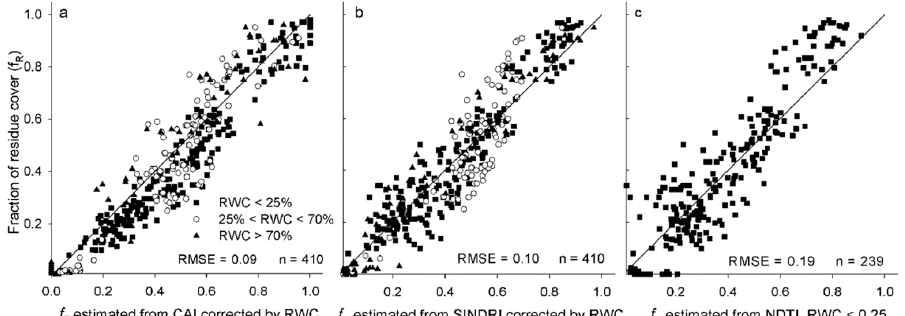
Figure 11. Measured residue cover and predicted residue cover with the multivariable linear model in which: ( a ) CAI was corrected by RWC estimated from the ratio of the narrow spectral bands R 1.5 /R 1.6 ; ( b ) SINDRI was corrected by RWC estimated from the ratio of the WorldView-3 SWIR3/SWIR6 spectral bands; and ( c ) NDTI was only used for RWC < 0.25. The solid line is the 1:1 line.